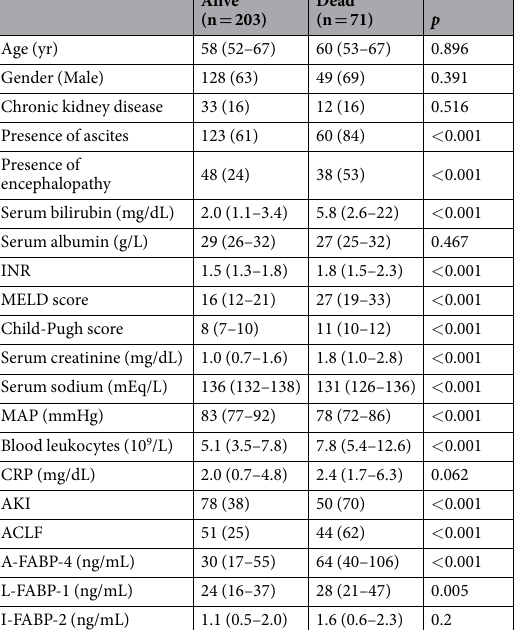
Table 4. Characteristics of patients at inclusion in the study according to 90-day survival. Categorical variables are expressed as numbers and percentages (in brackets), continuous variables are expressed as median (inter- quartile range). MELD, model of end stage liver disease; MAP: mean arterial pressure; AKI, acute kidney injury, ACLF: acute-on-chronic liver failure; A-FABP-4: plasma adipocyte fatty acid binding 4; L-FABP-1: plasma liver fatty acid binding 1; I-FABP-2: plasma intestinal fatty acid binding